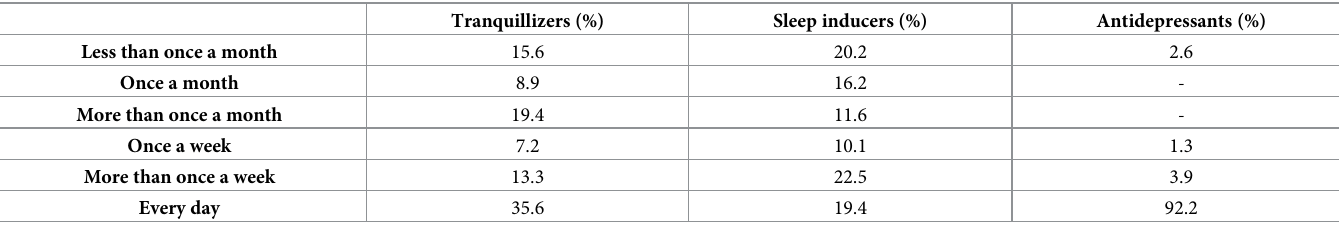
Table 3. Frequency of pharmaceuticals consumption.